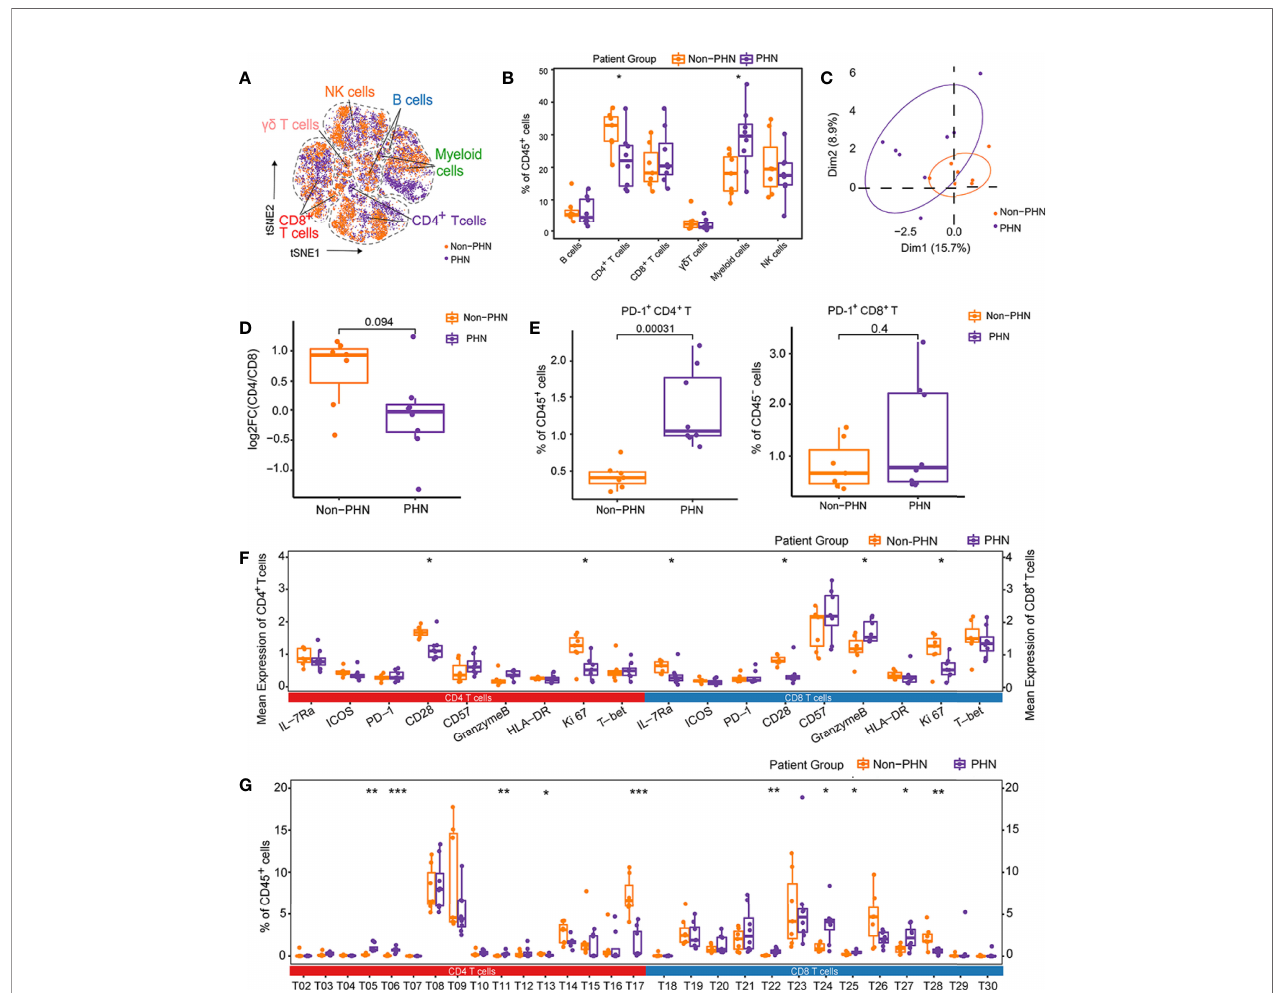
FIGURE 4 | Characteristics of immune landscape of patients with PHN and without PHN. (A) t-SNE plots identifying the difference of six main immune cell pro fi les, as shown in Figure 1A , between PHN and non-PHN. (B) Boxplots showing the frequencies of indicated clusters in the PHN and non-PHN groups. (C) The PCA projections of immune signatures between the PHN and non-PHN groups. (D) Boxplots showing the tendency of CD4/CD8 T cells ratio in the PHN group compared with the non-PHN group. (E) Boxplots showing the frequencies of PD-1 + CD4 + T cells and PD-1 + CD8 + T cells in PHN and non-PHN groups. (F) Boxplots displaying the mean expression levels of important cellular markers on CD4 + T cells and CD8 + T cells in the PHN and non-PHN groups. (G) Boxplots exhibiting the frequencies of T cell clusters in the PHN and non-PHN groups. *P < 0.05, **P < 0.01, ***P <